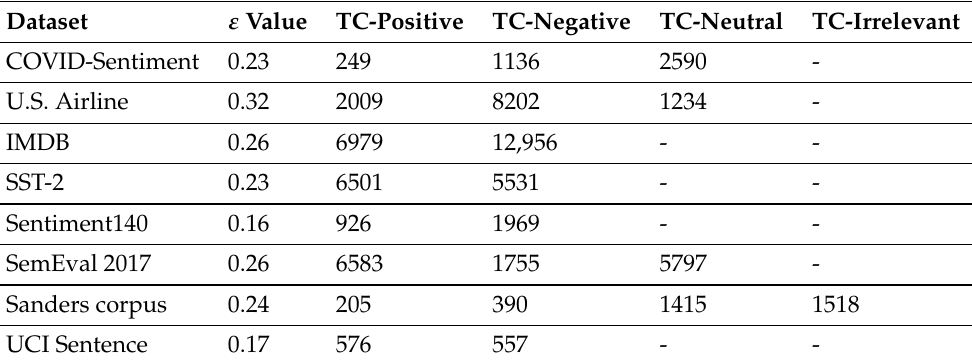
Table 3. Best tolerance ε value with sizes of tolerance classes for the positive, negative, neutral and irrelevant text polarities.